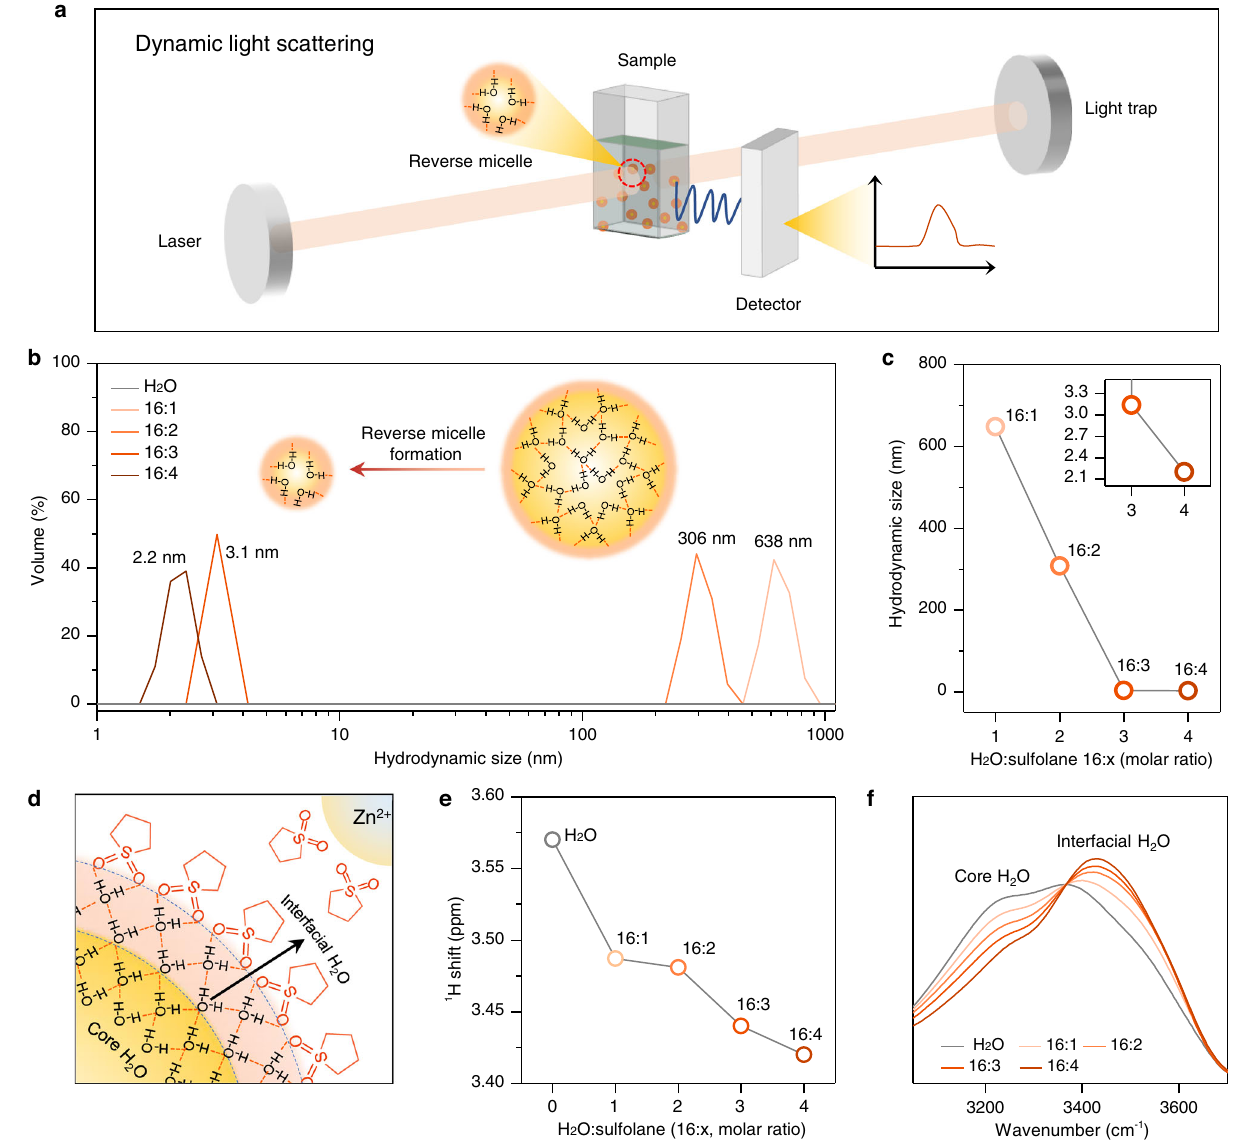
Fig.2|ThestructureoftheRMEandtheinterplaybetweenwaterandsulfolane. a SchematicillustrationoftheDLStechnique. b DLSanalysisforthehydrodynamic size distribution of the water clusters in the 3m Zn(OTf) 2 /H 2 O (H 2 O) and 3m Zn(OTf) 2 /H 2 O-sulfolane (H 2 O:sulfolane=16:x, x=1, 2, 3, 4, molar ratio) electrolytes. c The hydrodynamic size of water cluster as a function of the H 2 O:sulfolane molar